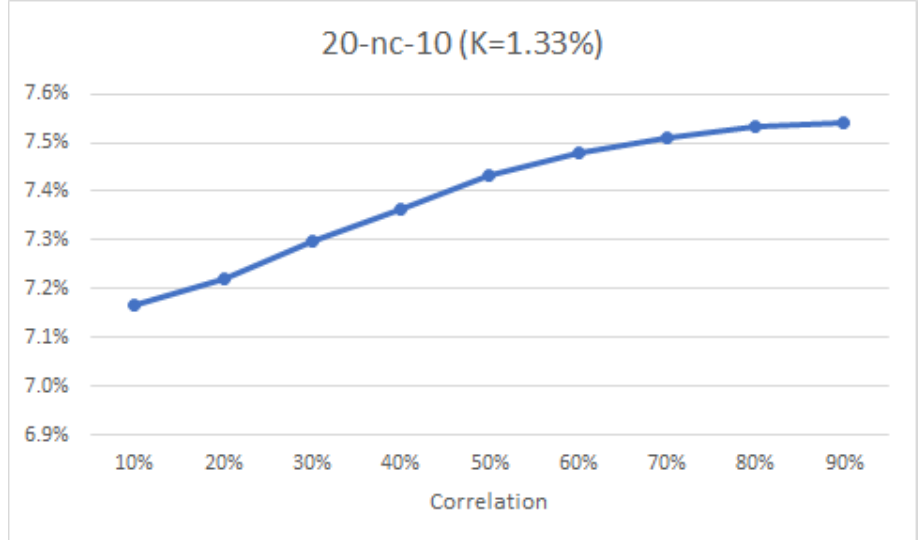
Figure 6. Prices of 20-nc-10 Bermudan swaption in a full-factor LIBOR market model under different base correlation